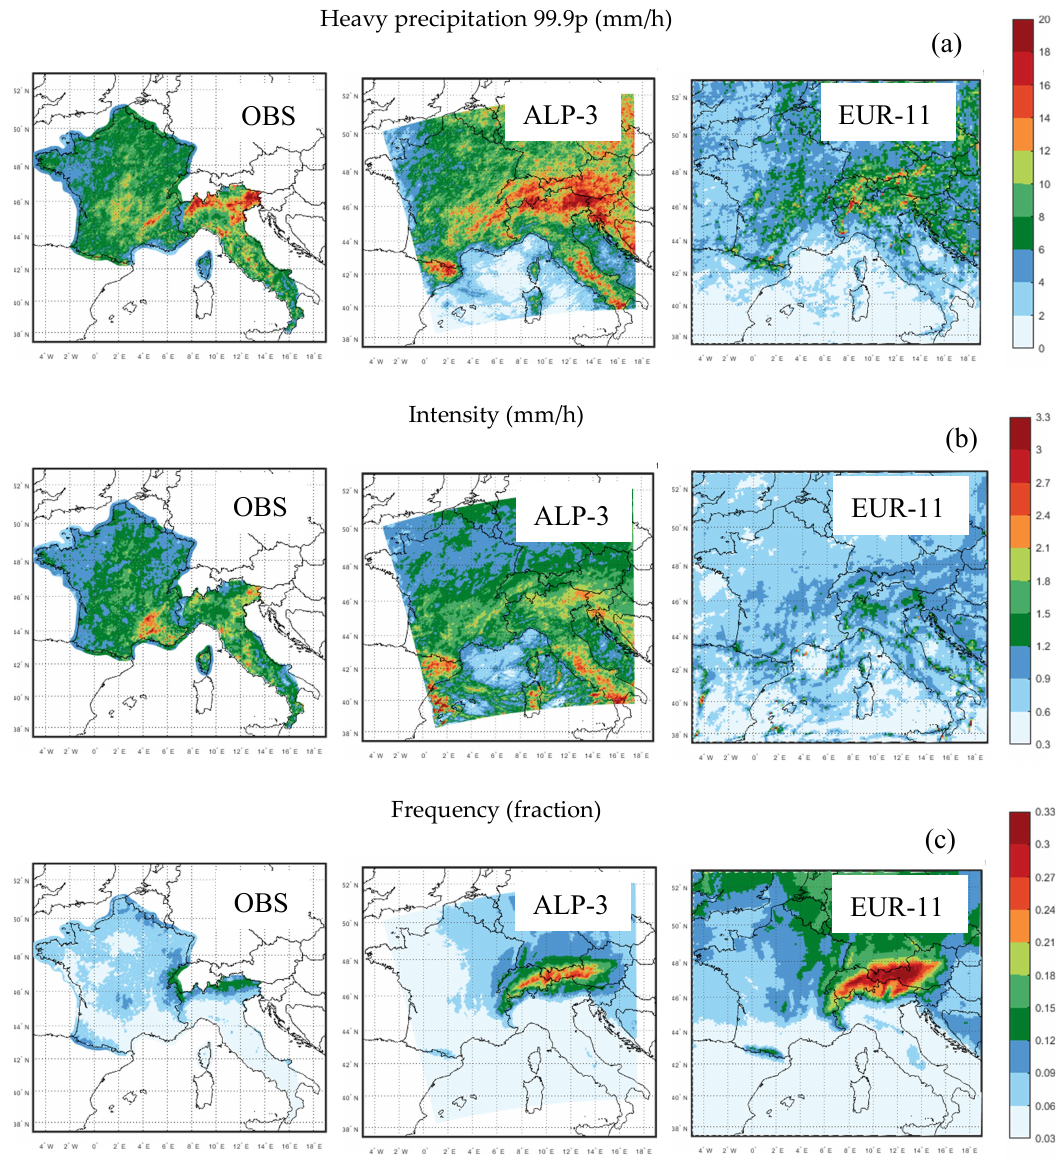
Figure 4. Spatial distribution at hourly scale of heavy precipitation 99.9p ( a ), intensity, ( b ) and frequency, ( c ) for observations OBS, ALP-3, and EUR-11 (evaluation experiments) over summer (JJA) 2001–2005. For OBS, observations over France derived from COMPHORE dataset, and over Italy, derived from GRIPHO dataset are